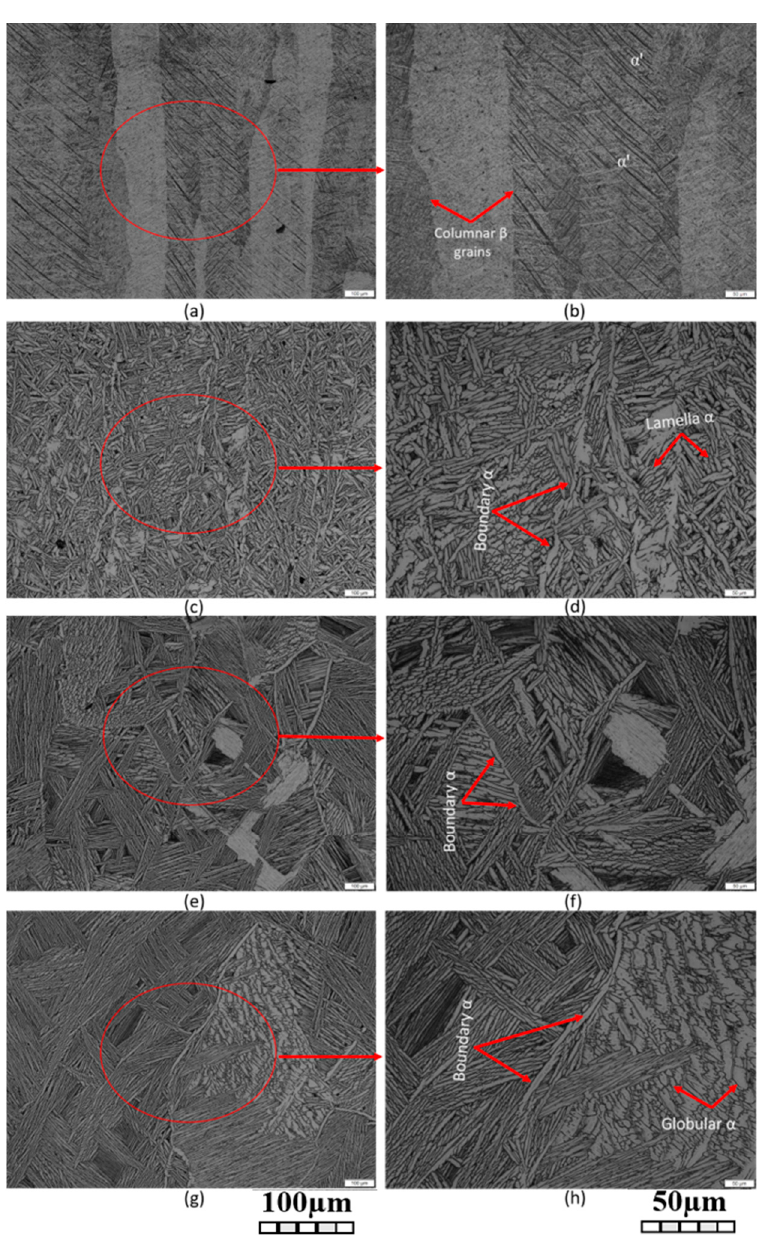
Figure 5. Optical microstructures of the samples: ( a ) As-built; ( b ) as-built zoom in; ( c ) 2 h; ( d ) 2 h zoom in; ( e ) 4 h; ( f ) 4 h zoom in; ( g ) 8 h; ( h ) 8 h zoom in.